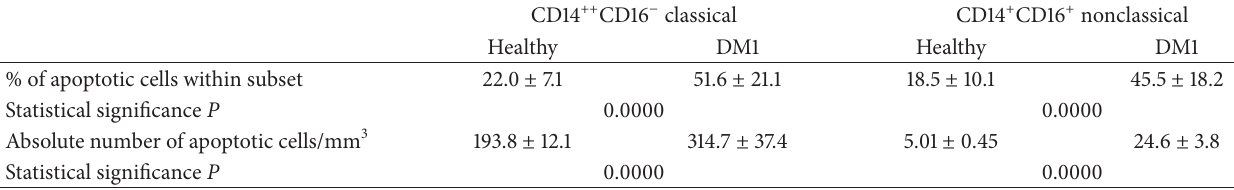
Table 2: Apoptotic cells within the monocyte